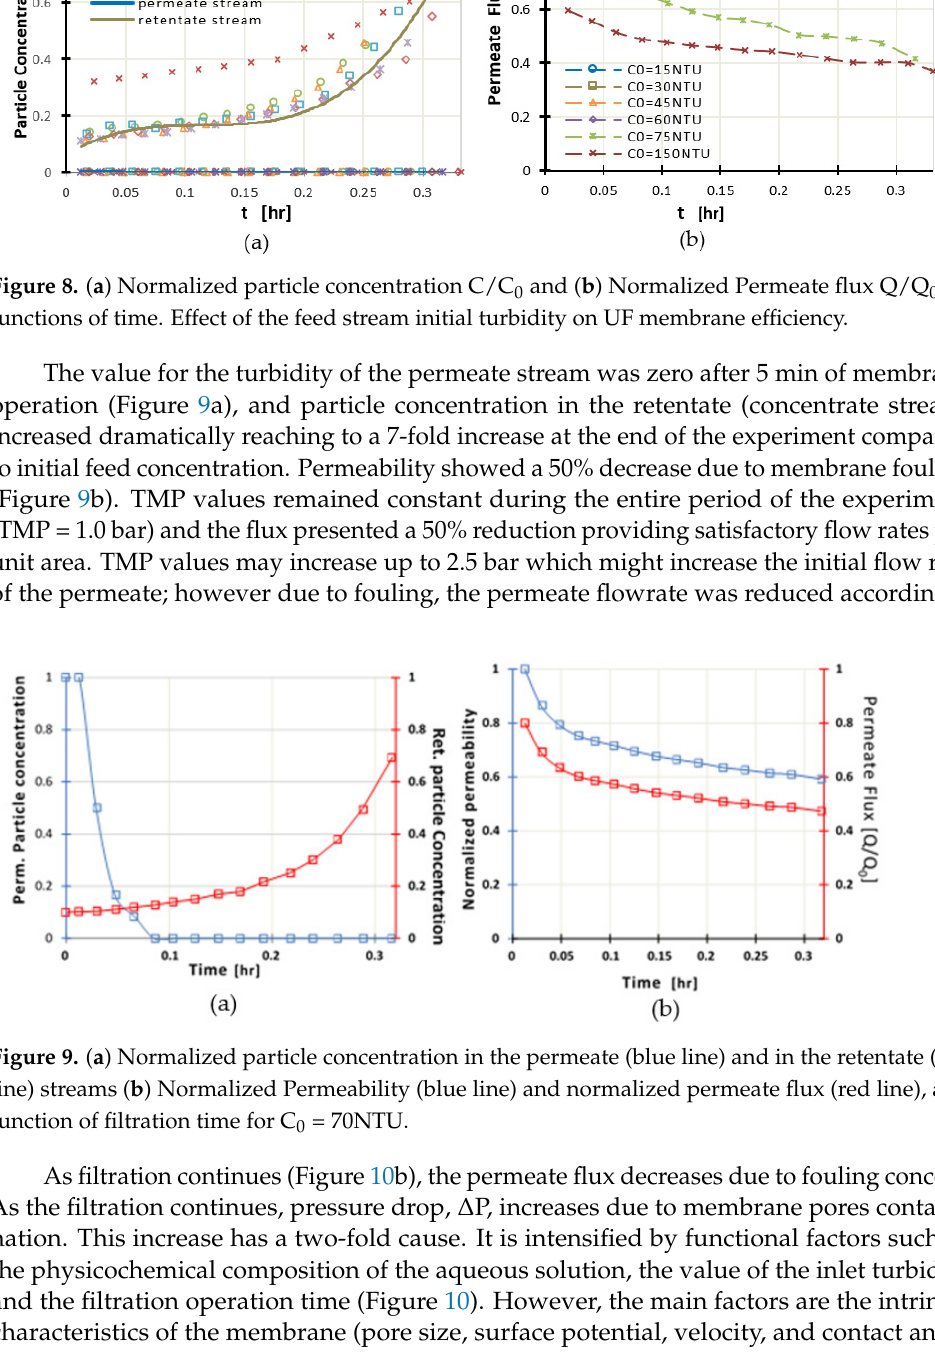
9 of 15 Figure 7. ( a ) Normalized particle concentration and ( b ) Pressure drop, as functions of duration time, at two different depths of the filter and two grain size distributions for packing material, at C 0 = 70NTU and V = 1.85 mm/s. 3.2. Membrane Filtration Performance